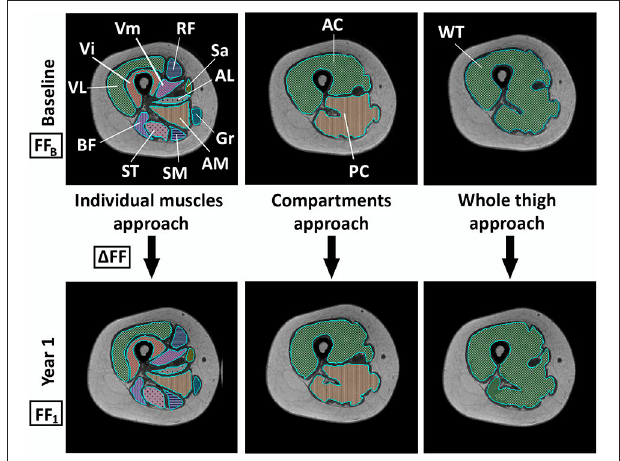
FIGURE 1 | Schema of the three different analysis approaches at baseline visit and visit 1. VL, vastus lateralis; Vi, vastus intermedius; RF, rectus femoris; Vm, vastus medialis; Sa, sartorius; AL, adductor longus; Gr, gracilis; AM, adductor major; SM, semimembranosus; ST, semitendinosus; BF, biceps femoris; AC, anterior compartment; PC, posteromedial compartment; WT, whole thigh; FF B , fat fraction at baseline; 1 FF, fat fraction increment between baseline and visit 1; FF 1 , fat fraction at visit